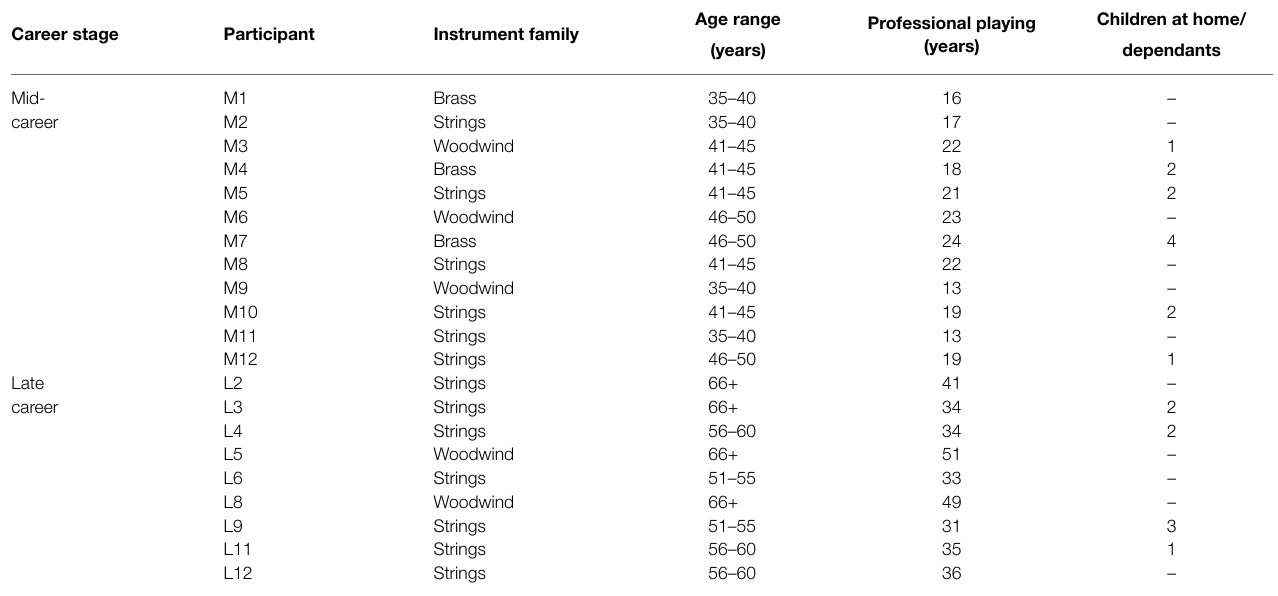
TABLE 1 | Summary of participant